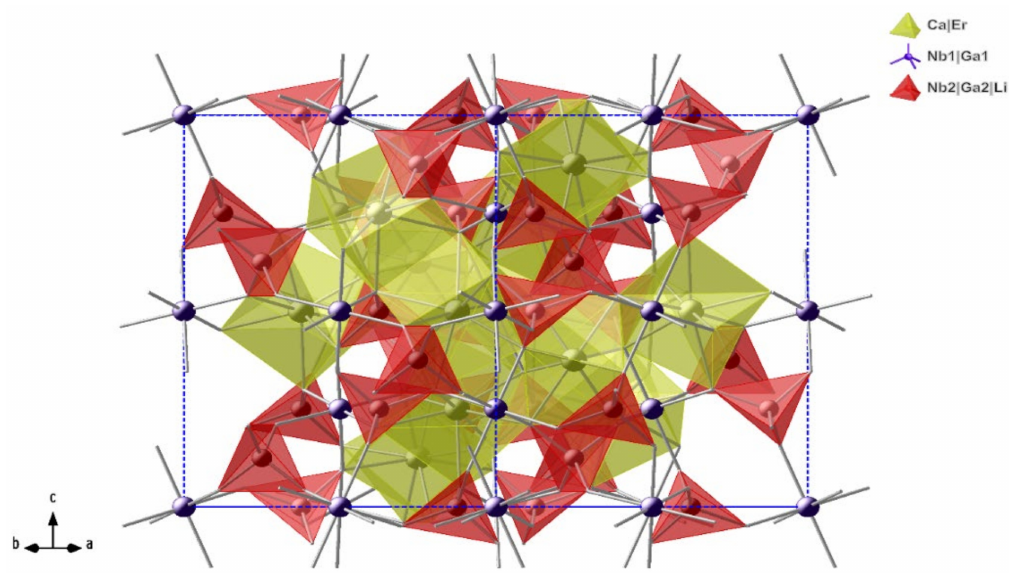
Figure 4. Unit-cell representation of Er:CLNGG crystal in the (110) crystallographic plan. Table 3. Bond lengths and intermetallic distances (Å) in 10, 15 and 30 at % Er:CLNGG crystals. Distances(Å) 10 at.% Er:CLNGG 15 at.% Er:CLNGG 30 at.% Er:CLNGG